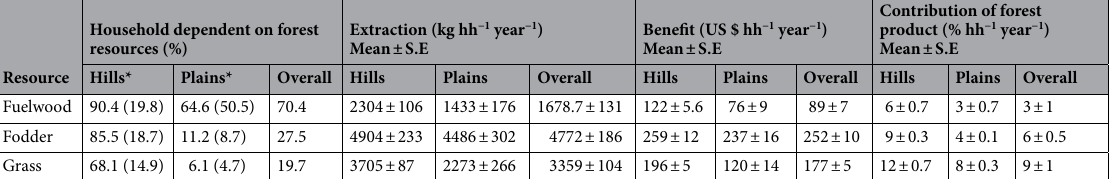
Table 2. Benefits derived from the forest corridor linking the Rajaji and Corbett Tiger Reserves, Uttarakhand, India. (* values in parentheses indicate percentage of total households sampled)